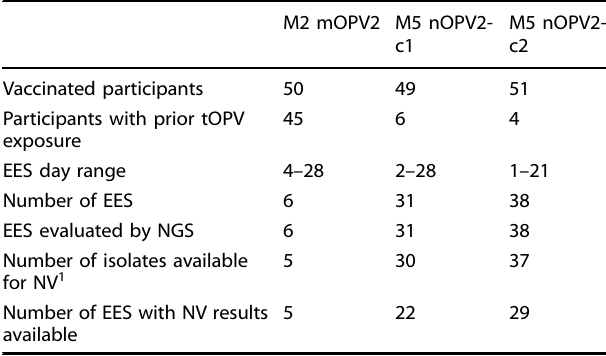
Table 1. Sample availability (post dose1) from children and genetic stability analyses